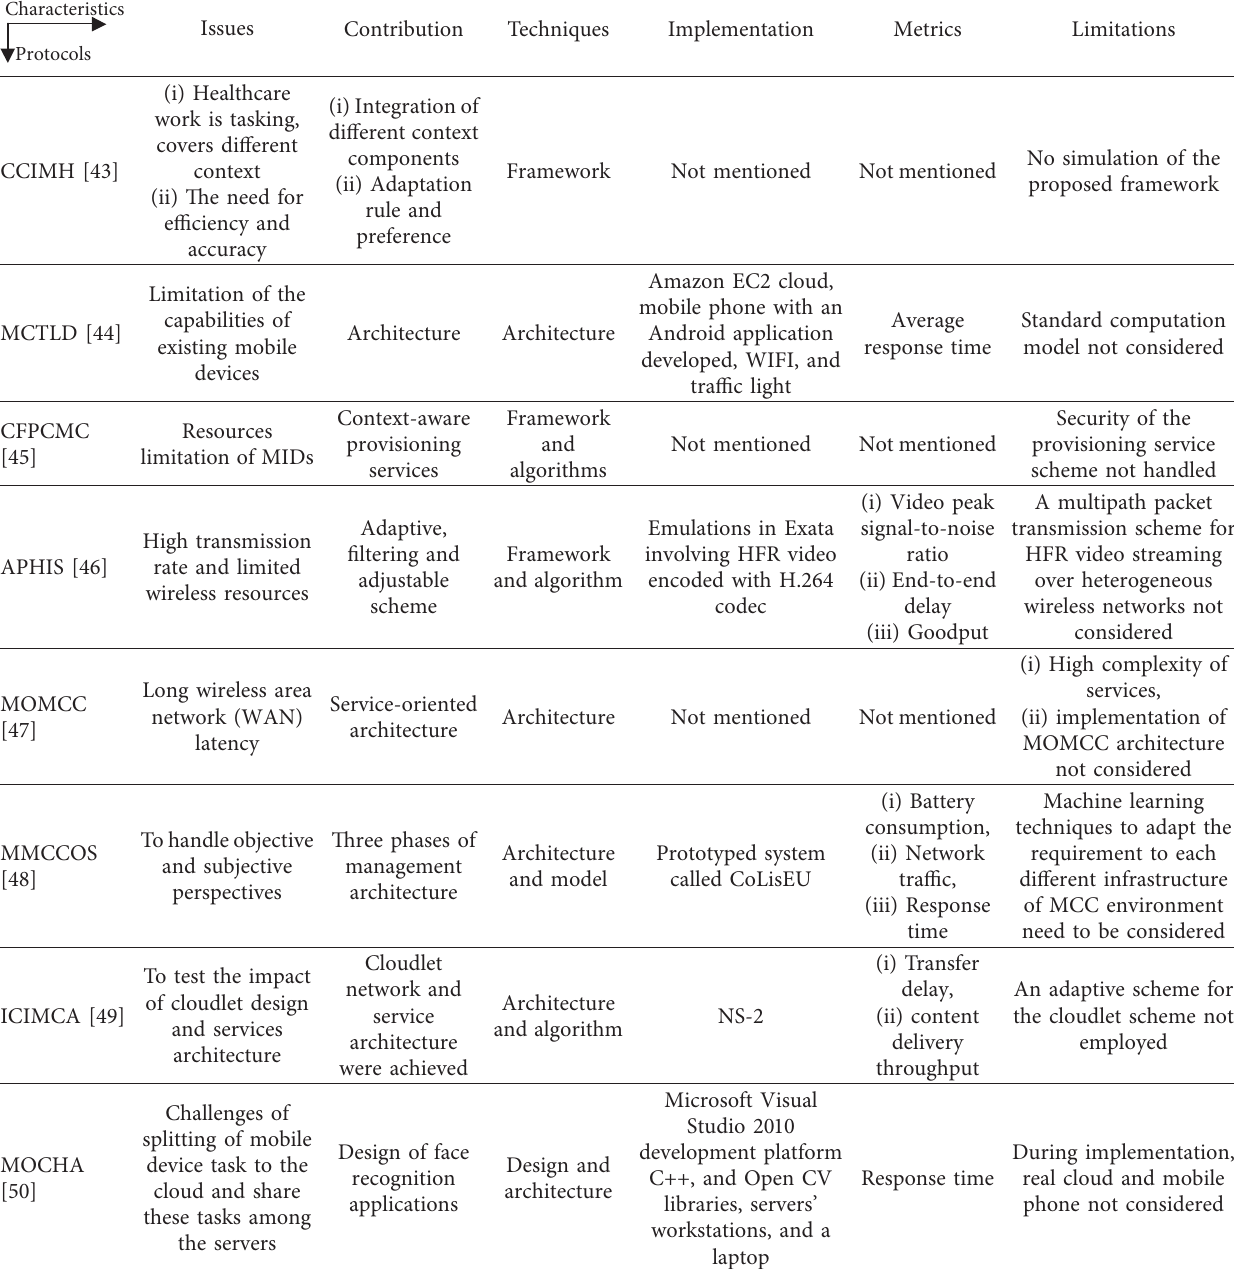
Table 4: Summary of application development techniques in